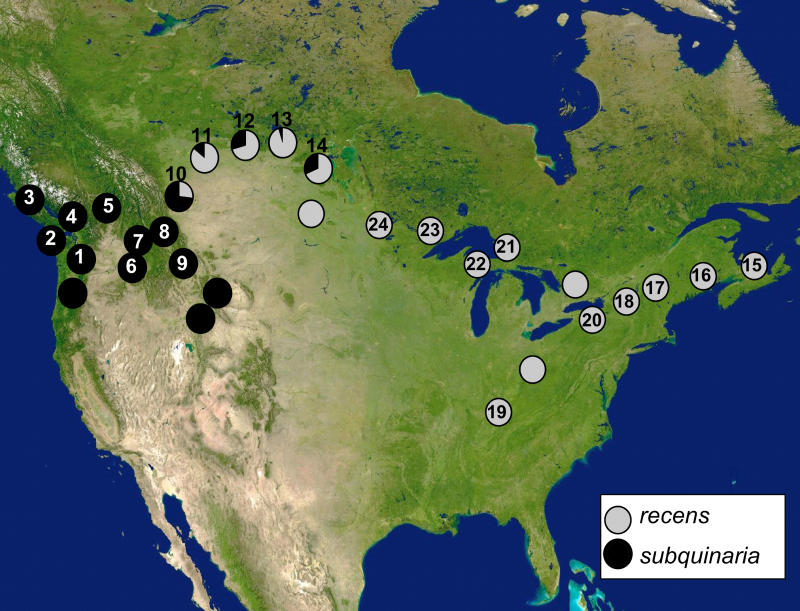
Collection Sites and Relative Abundance of D. recens (Gray) and D. subquinaria (Black)Satellite imagery courtesy of http://www.GlobeXplorer.com.